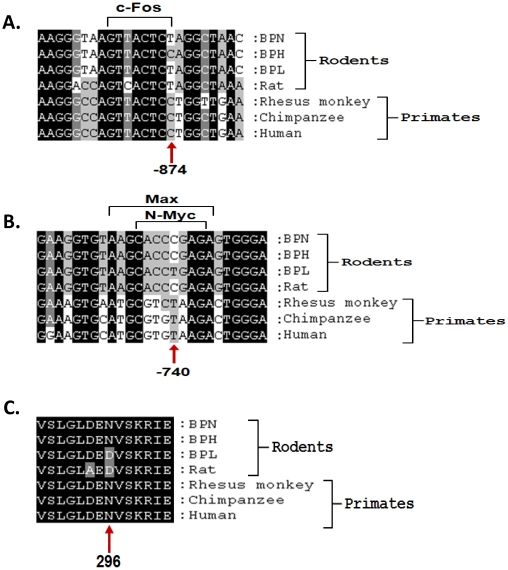
Conservation of Hmgcr sequences among mammalian species.Alignment of orthologous sequences around the promoter polymorphisms C-874T (panel A), C-740T (panel B) and the amino acid variant N296D (panel C) in mouse Hmgcr was carried out using Clustal W. The promoter as well as protein sequences were found to be highly conserved among the mammals. The binding motifs for the transcription factors c-Fos (panel A) and n-Myc/Max (panel B) are shown within brackets. The BPH, BPL and BPN sequences were determined in this study (as described in the Materials and Methods section) while the other sequences were obtained from UCSC/NCBI public databases; the accession numbers for the promoter sequences are: human, NM_000859.2; chimpanzee, XM_001148324.1; rhesus monkey, XM_001104607.2; rat, NM_013134.2, and the accession numbers for the amino acids sequences are: human, NP_000850.1; chimpanzee, XP_001148324.1; rhesus monkey, XP_001104607.1; rat, NP_037266.2). The positions of the nucleotide/amino acid variations are indicated by upward arrows.